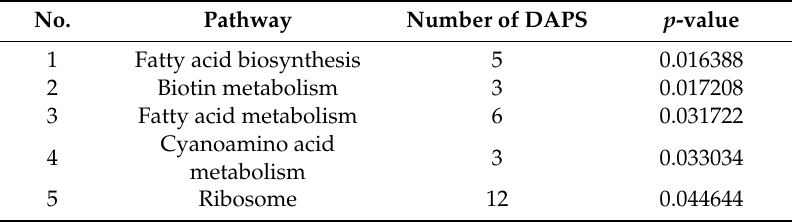
Table 1. Significantly enriched pathway annotation of DAPS identified by iTRAQ.